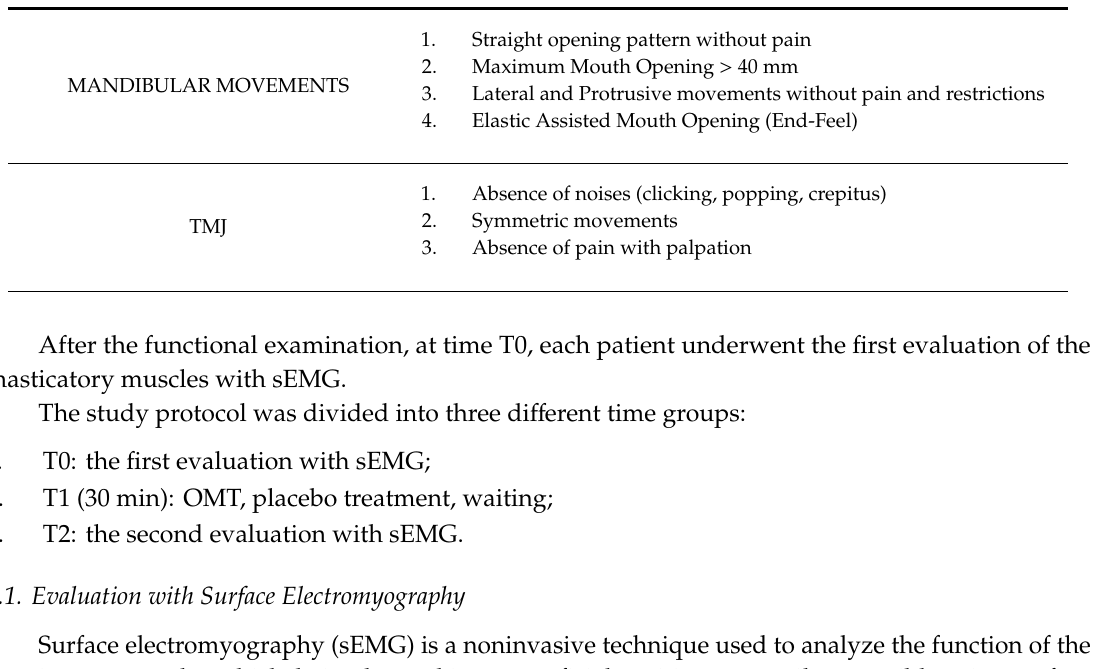
Table 1. The criteria used to assess the absence of